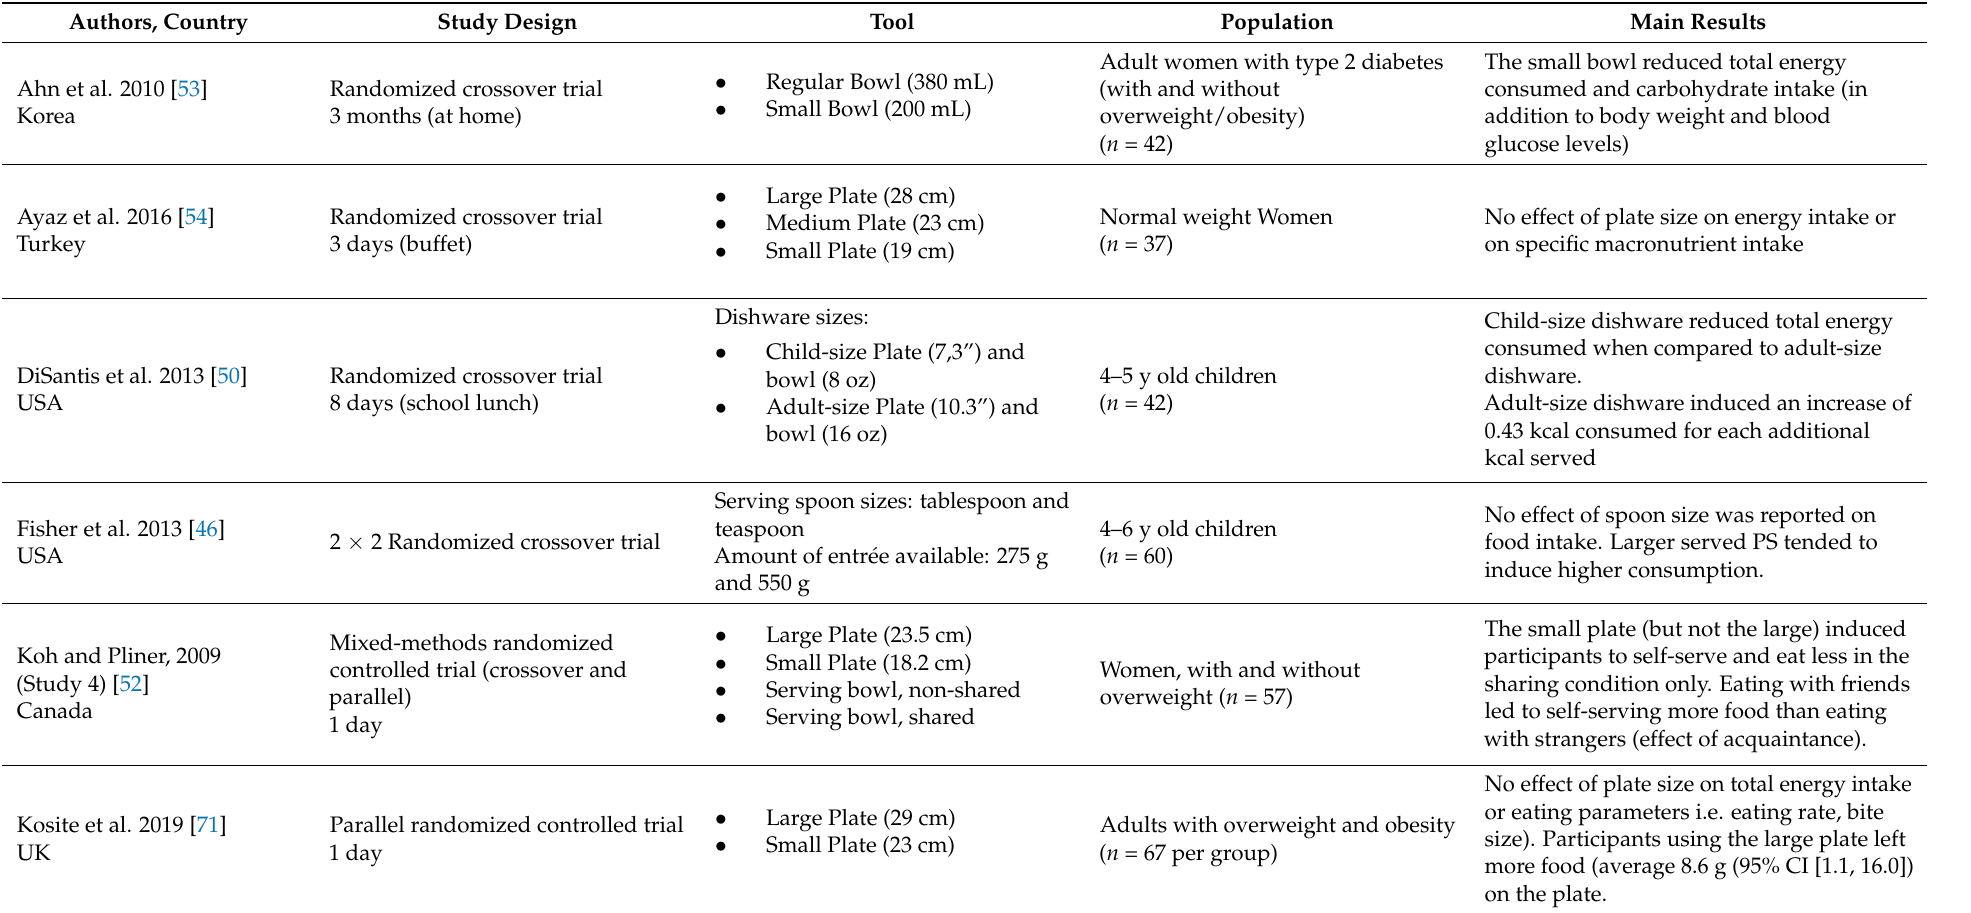
Table 5. Results of studies reporting changes in portion size intake (in consumed amounts or